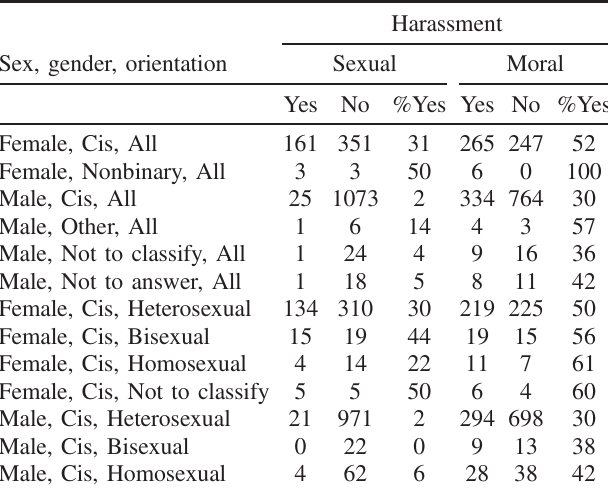
TABLE V. Sexual and moral harassment by category of sex, gender identity, and sexual orientation. Only categories with at least one response are shown. “ All ” refers to all categories of sexual